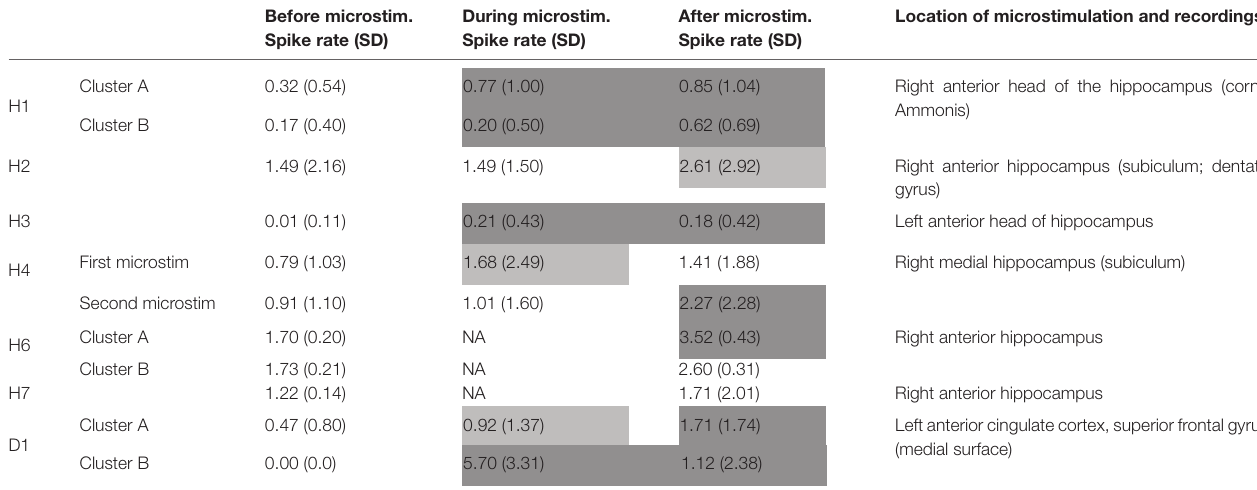
TABLE 2 | Spike frequency changes with microstimulation. Before microstim. During microstim. After microstim. Location of microstimulation and recordings Spike rate (SD)